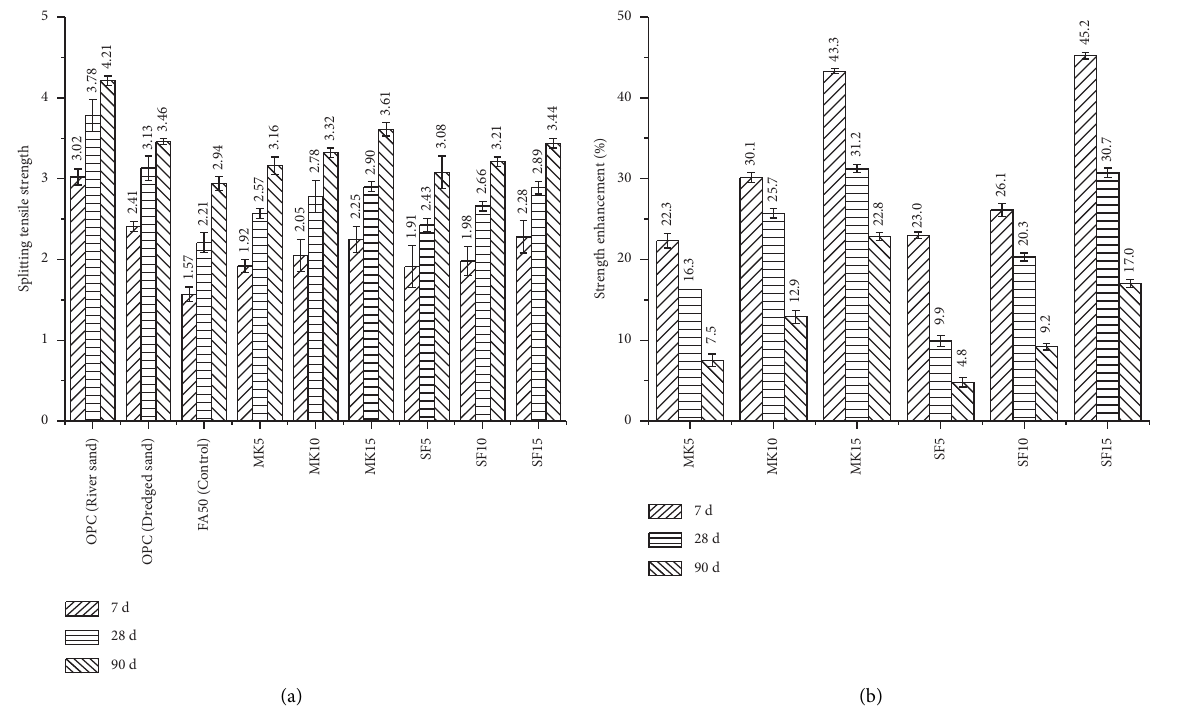
Figure 5: (a) Splitting tensile strength of mortars and (b) its growth rate.